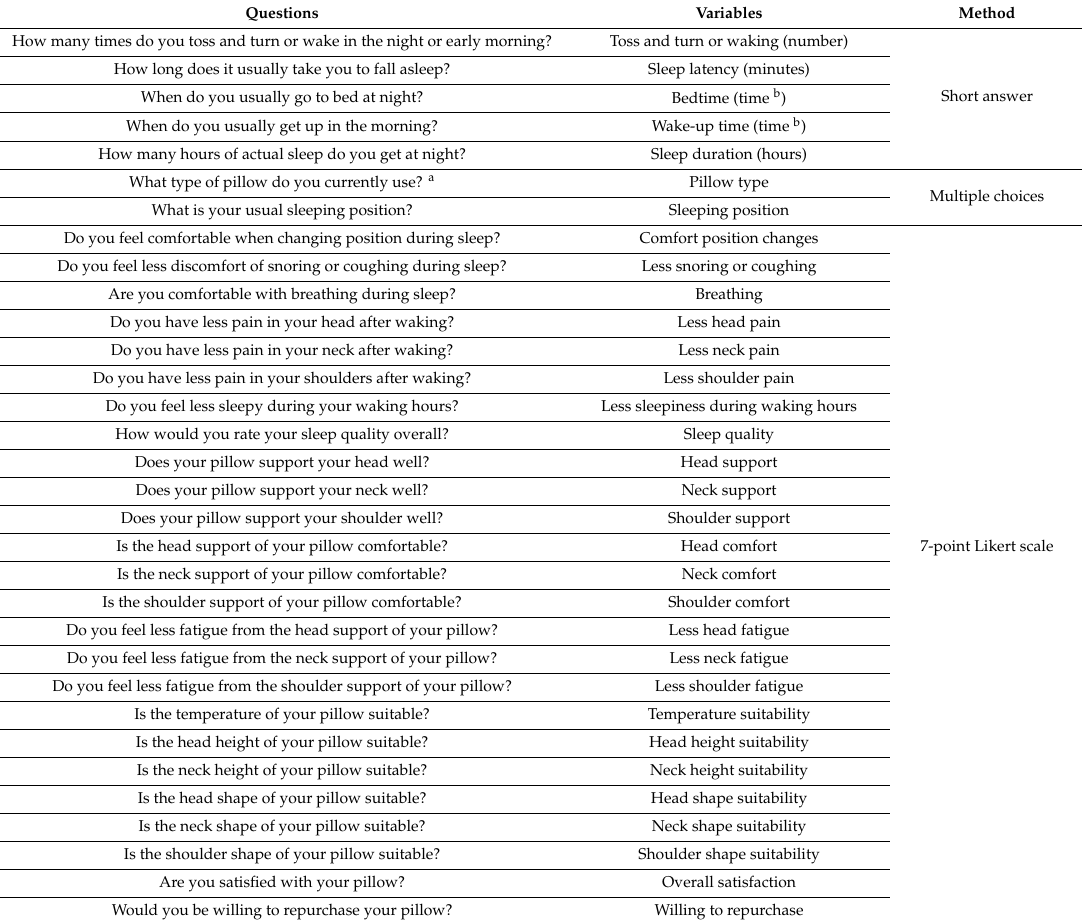
Table 1. Questionnaire to assess sleep habits, sleeping symptoms and the comfort and support characteristics of